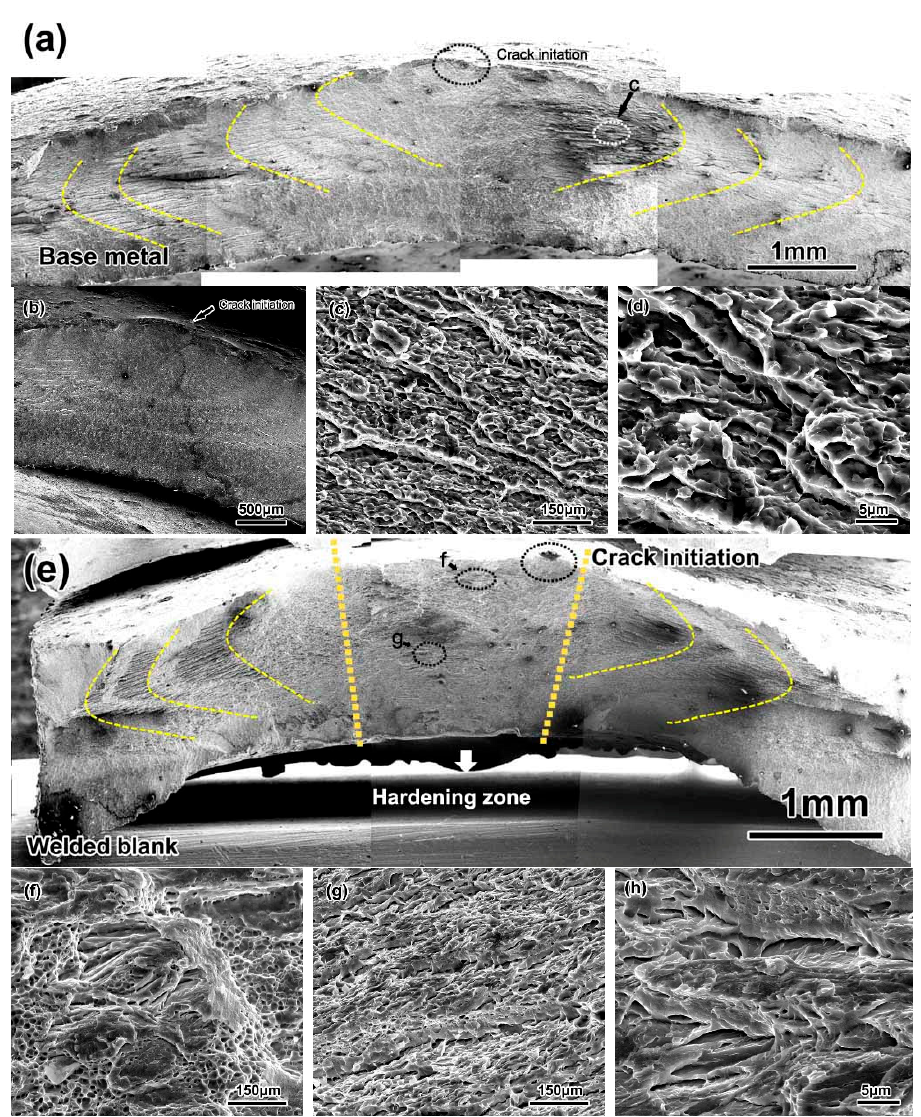
Figure 13. Typical fracture surface morphology of cupping test of ( a – d ) BM and ( e – h ) laser-welded joint (2 kW, 1.2 m/min).